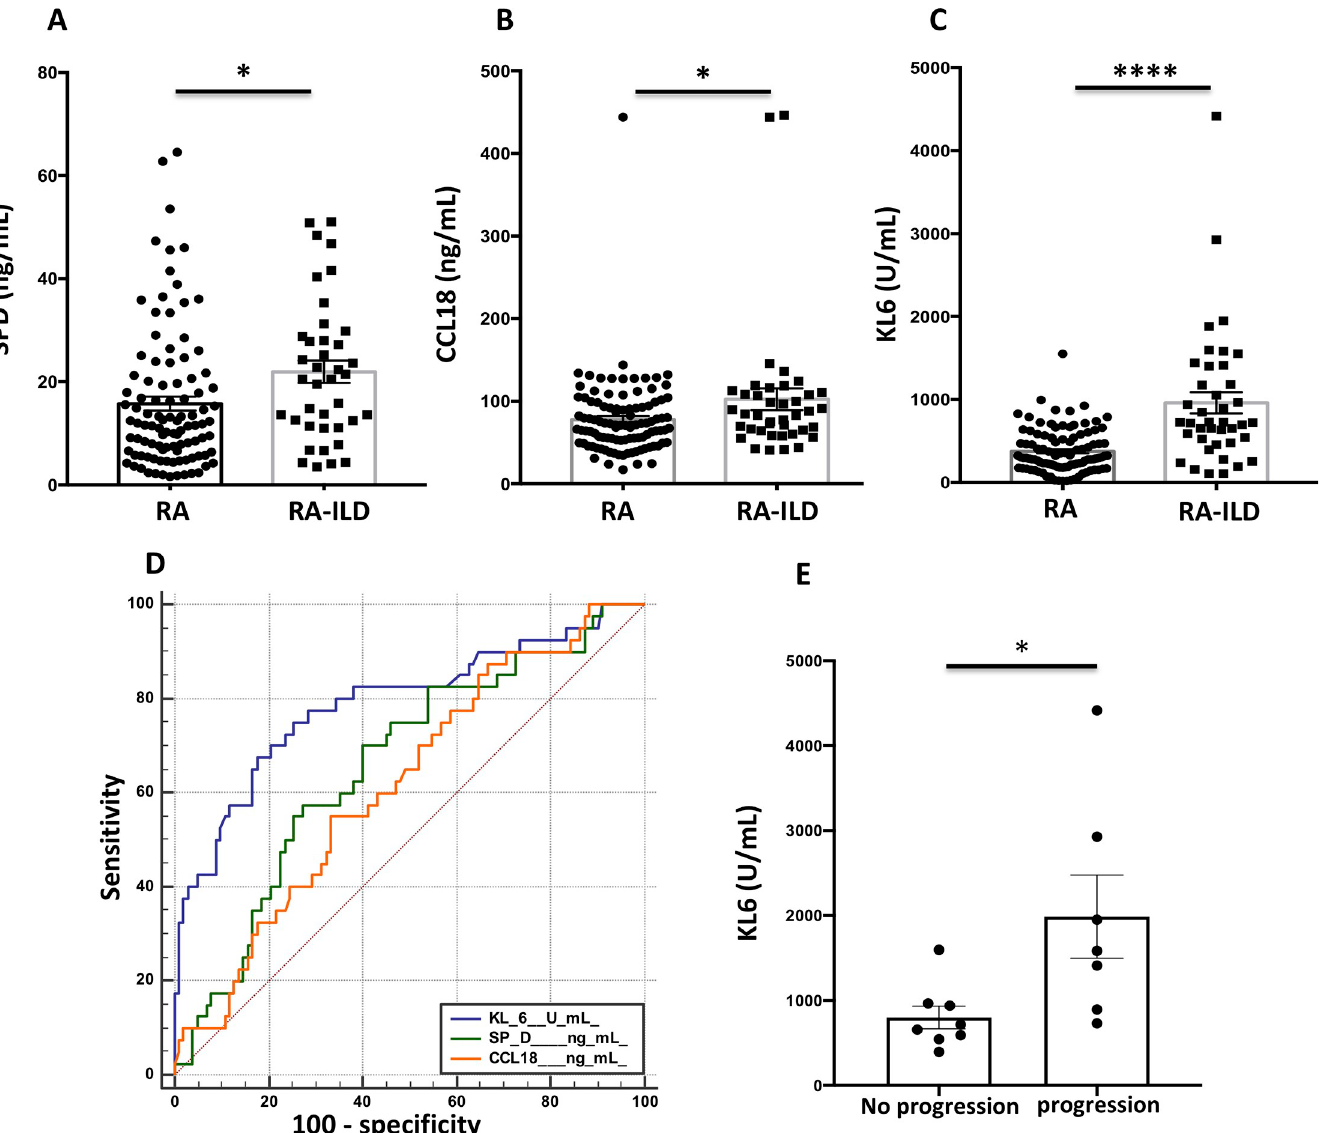
Fig 1. Concentrations of serum markers, diagnostic value and performance of KL-6 for the progression of rheumatoid arthritis-associated interstitial lung disease. A-C, Concentrations of SPD (ng/mL) (A), CCL18 (ng/mL) (B) and KL-6 (U/mL) (C) in patients with rheumatoid arthritis (RA) with or without associated interstitial lung disease. D, ROC curve illustrating the diagnostic value of SPD, CCL18 and KL-6 for diagnosis of interstitial lung disease in patients with rheumatoid arthritis. E, Concentrations of KL-6 (U/mL) according to the progression of rheumatoid arthritis (RA)-associated interstitial lung disease (ILD), assessed by on chest high-resolution computed tomography (HRCT) and pulmonary function tests. � p < 0.05 and ���� p < 0.0001 by Student’s t test.